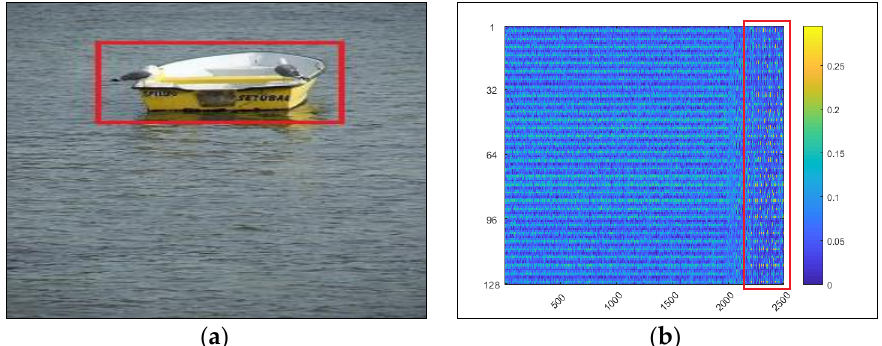
Figure 1. Observing the burstiness property of the features in a natural image. ( a ) An image with the object in a red bounding box; ( b ) The visualization of the Dense SIFT descriptors sampled from